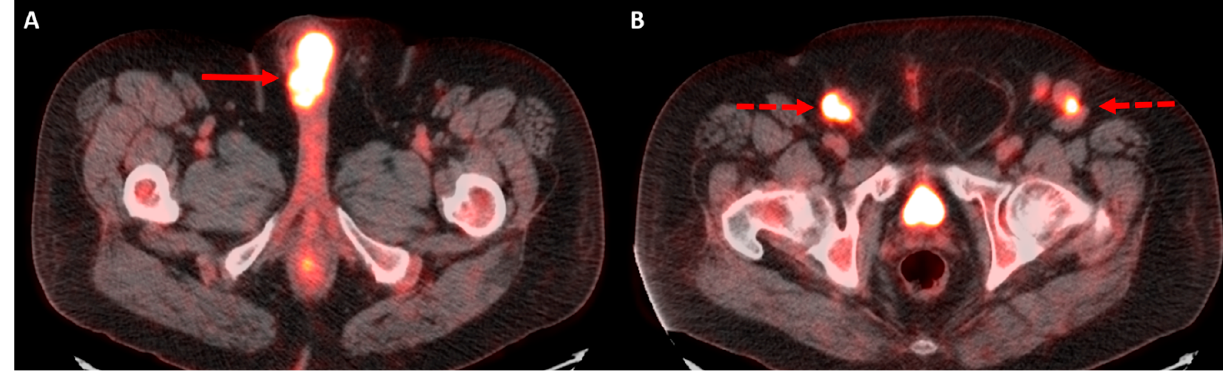
Figure 3. 66-year-old male with history of penile cancer status post penectomy presents with suspected recurrence on clinical exam. Restaging FDG-PET/CT demonstrates an intensely hyper- metabolic mass at the penectomy bed ( A , solid arrow) and bilateral hypermetabolic inguinal lymph node metastases ( B , dashed arrows).